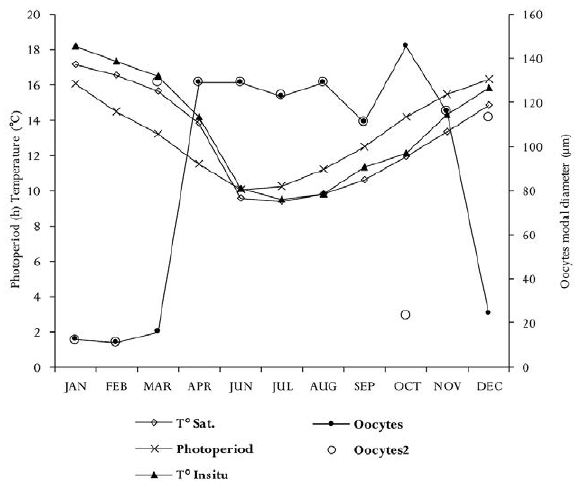
Fig. 4. – Variation in seawater surface temperature (satellite and in situ measurements), photoperiod and female oocyte modal diameter (oocytes 1 and 2 when more than one modal diameter was found) throughout the year 2012. Fig. 5. – Nacella magellanica seasonal percent values for proteins (black bars), lipids (dark-grey bars) and carbohydrates (grid bars), and body weight for females (solid line) and males (hatched line) in 2012. Abbreviations: M, males; F,